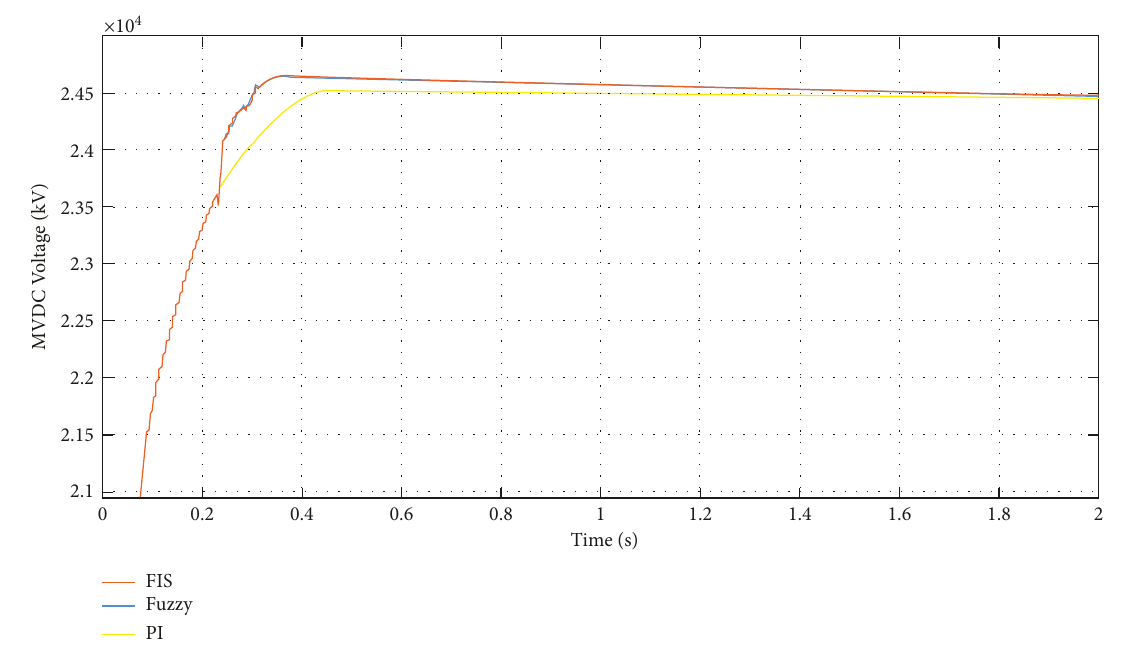
Figure 16: MV DC voltage of FS-MMC with different controllers.